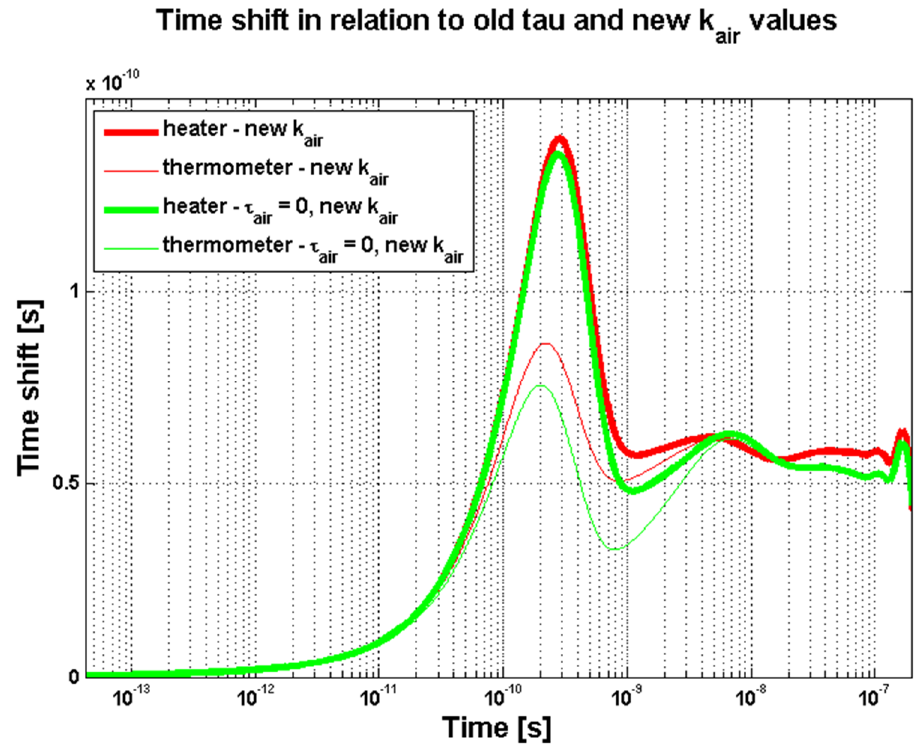
Figure 6. Time shifts over the time for temperature rises observed in the heat source and temperature sensor (including analysis in Section 2.4).